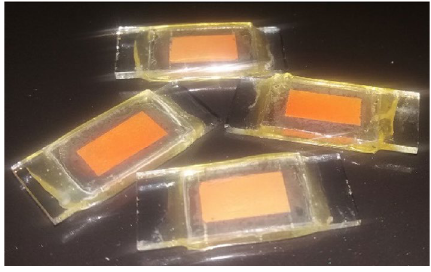
Fig. 2 Assembled bixin-sensitized solar